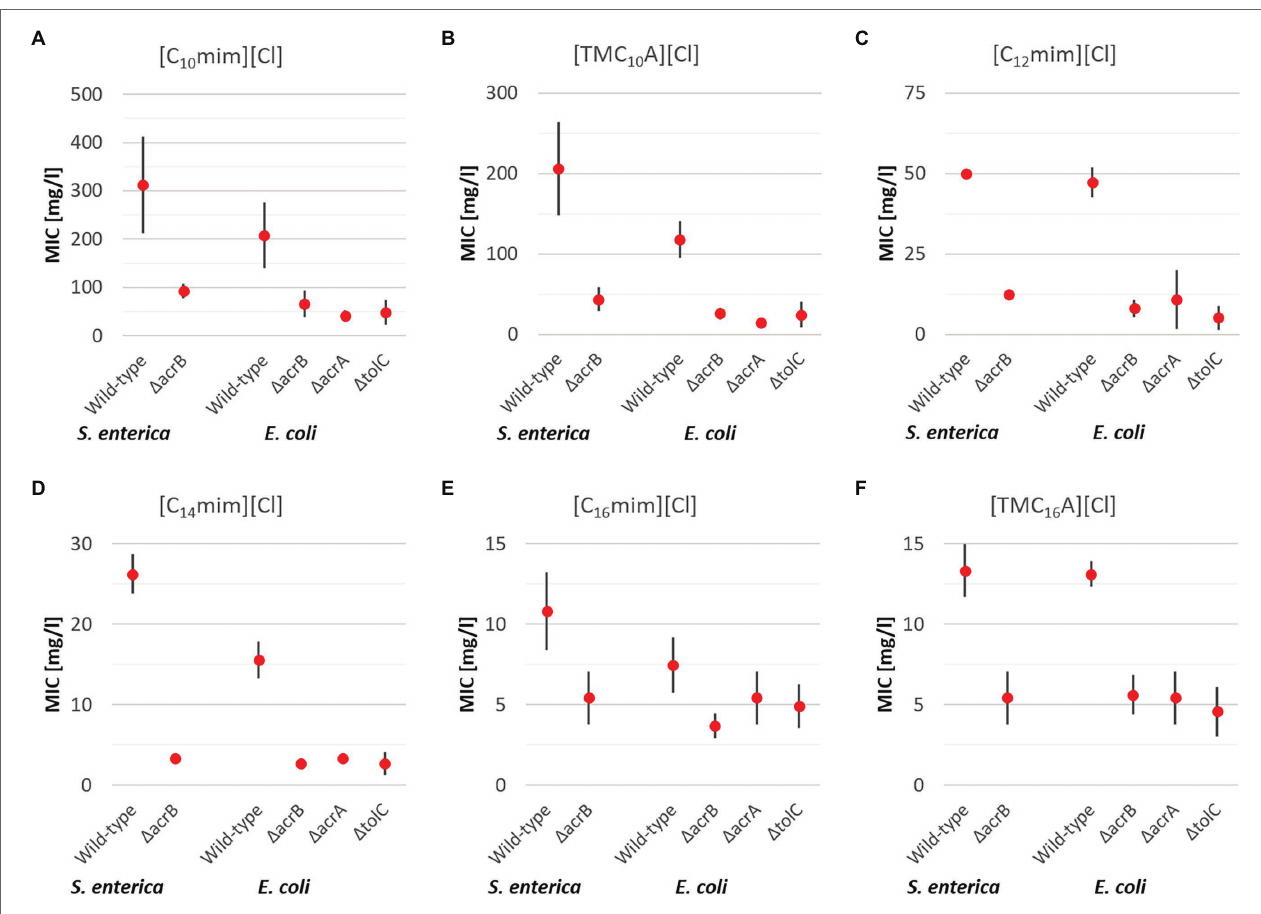
FIGURE 2 | Mean MIC values for antimicrobial ionic liquids (ILs) with one elongated alkyl side chain [C 10 mim][Cl] (A) , [TMC 10 A][Cl] (B) , [C 12 mim][Cl] (C) , [C 14 mim][Cl] (D) ,